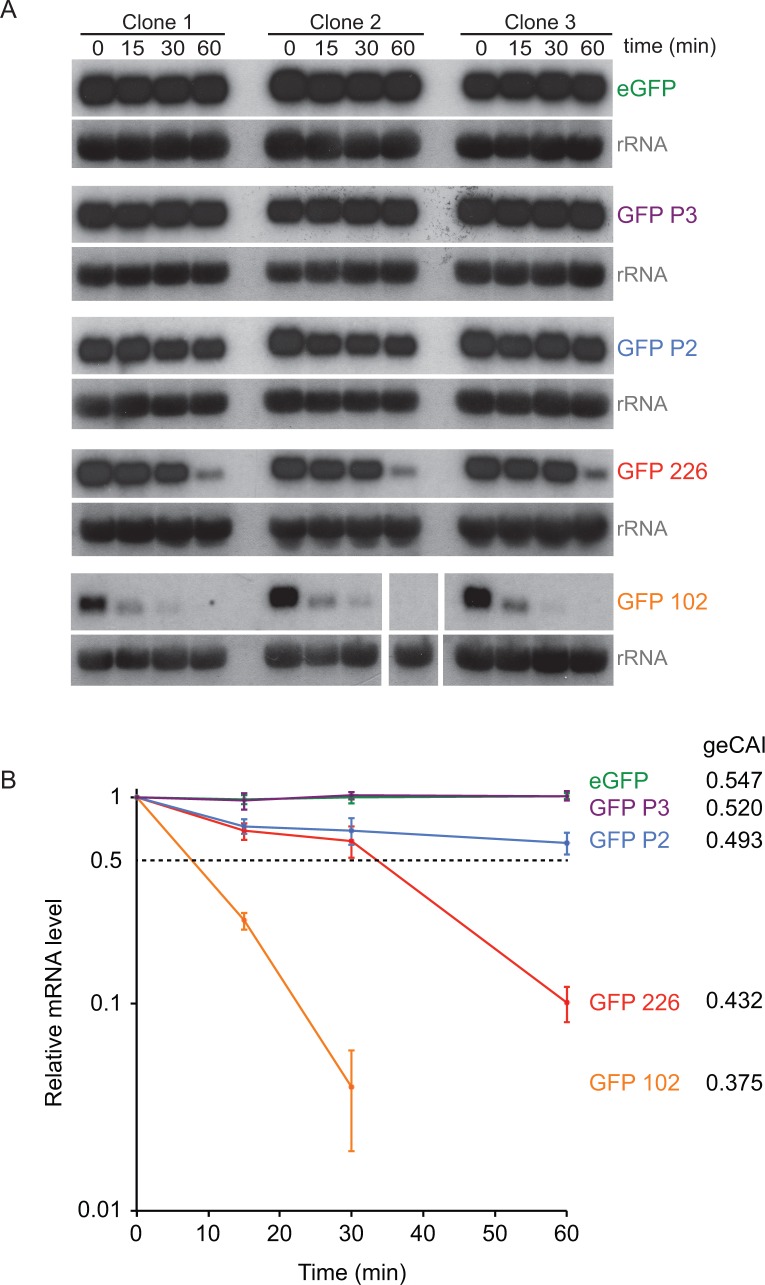
geCAI scores are a major determinant of mRNA half-lives.(A) Northern blots to measure mRNA levels over a time course after inhibition of mRNA maturation with sinefungin in cell lines expression one of five differently coded GFPs. Three independent clones for each of five cell lines are shown and each blot was probed with the cognate GFP ORF; blots were exposed for a range of times. rRNA was used as a loading control for GFP mRNA quantitation. The identity and geCAI score for each GFP ORF is shown to the right. (B) Decay of GFP mRNAs after sinefungin addition. The mRNAs were quantified by phosphorimaging of the northern blots and each value adjusted for loading based on rRNA. The mRNA levels (±standard error) were plotted against time after being normalised to the zero timepoint.